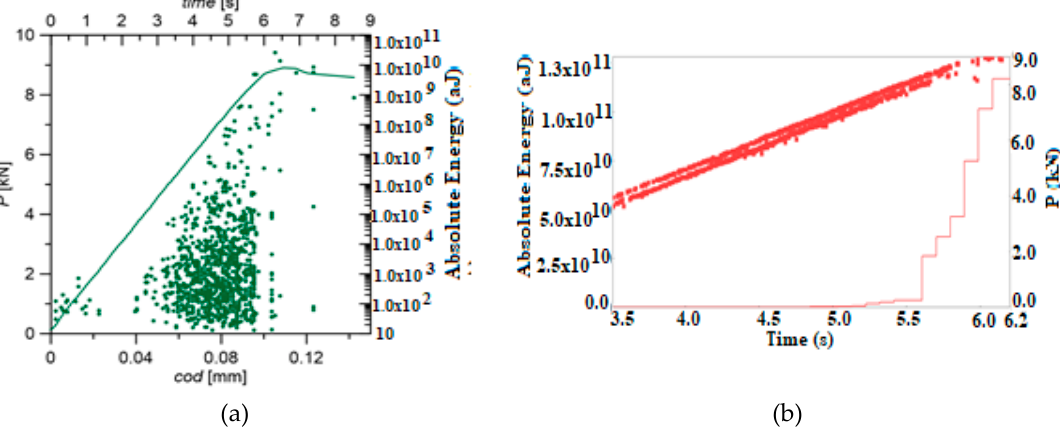
Figure 3. The graph of specimen loading ( a ) with absolute energy of AE signals (aJ) and ( b ) graph cumulative absolute energy vs. load on time from 3.5 to 6.2 s. The graphs show AE parameters without using the clustering method (identification) of destructive processes.